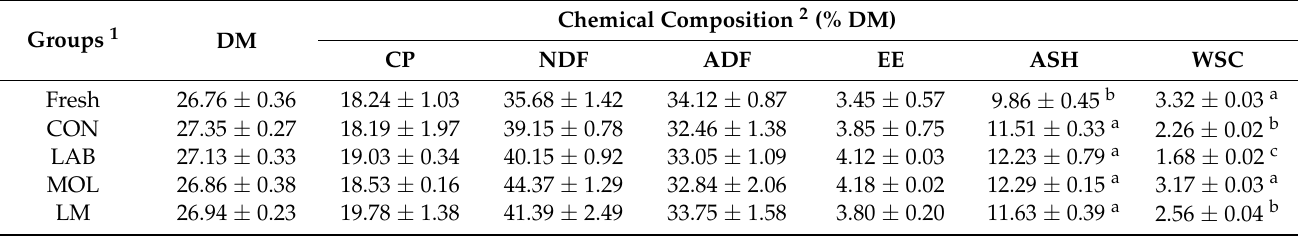
Table 1. Effects of different additives on the chemical composition of paper mulberry